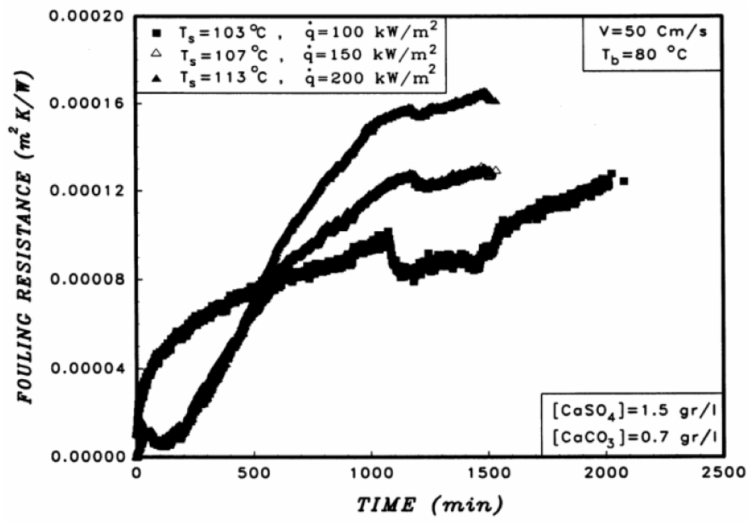
Figure 12. Variation of fouling resistance with time at different surface temperatures